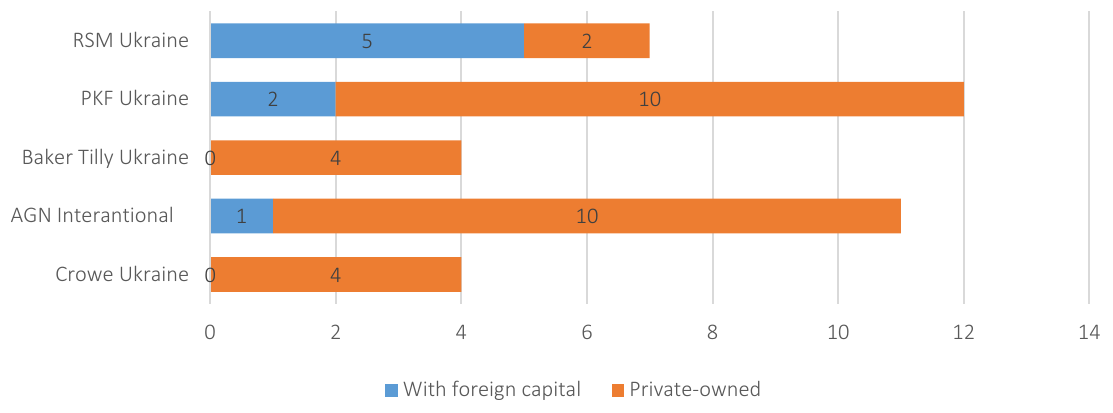
Figure 5. Audit portfolio of Ukrainian banks of the mid-tier audit companies